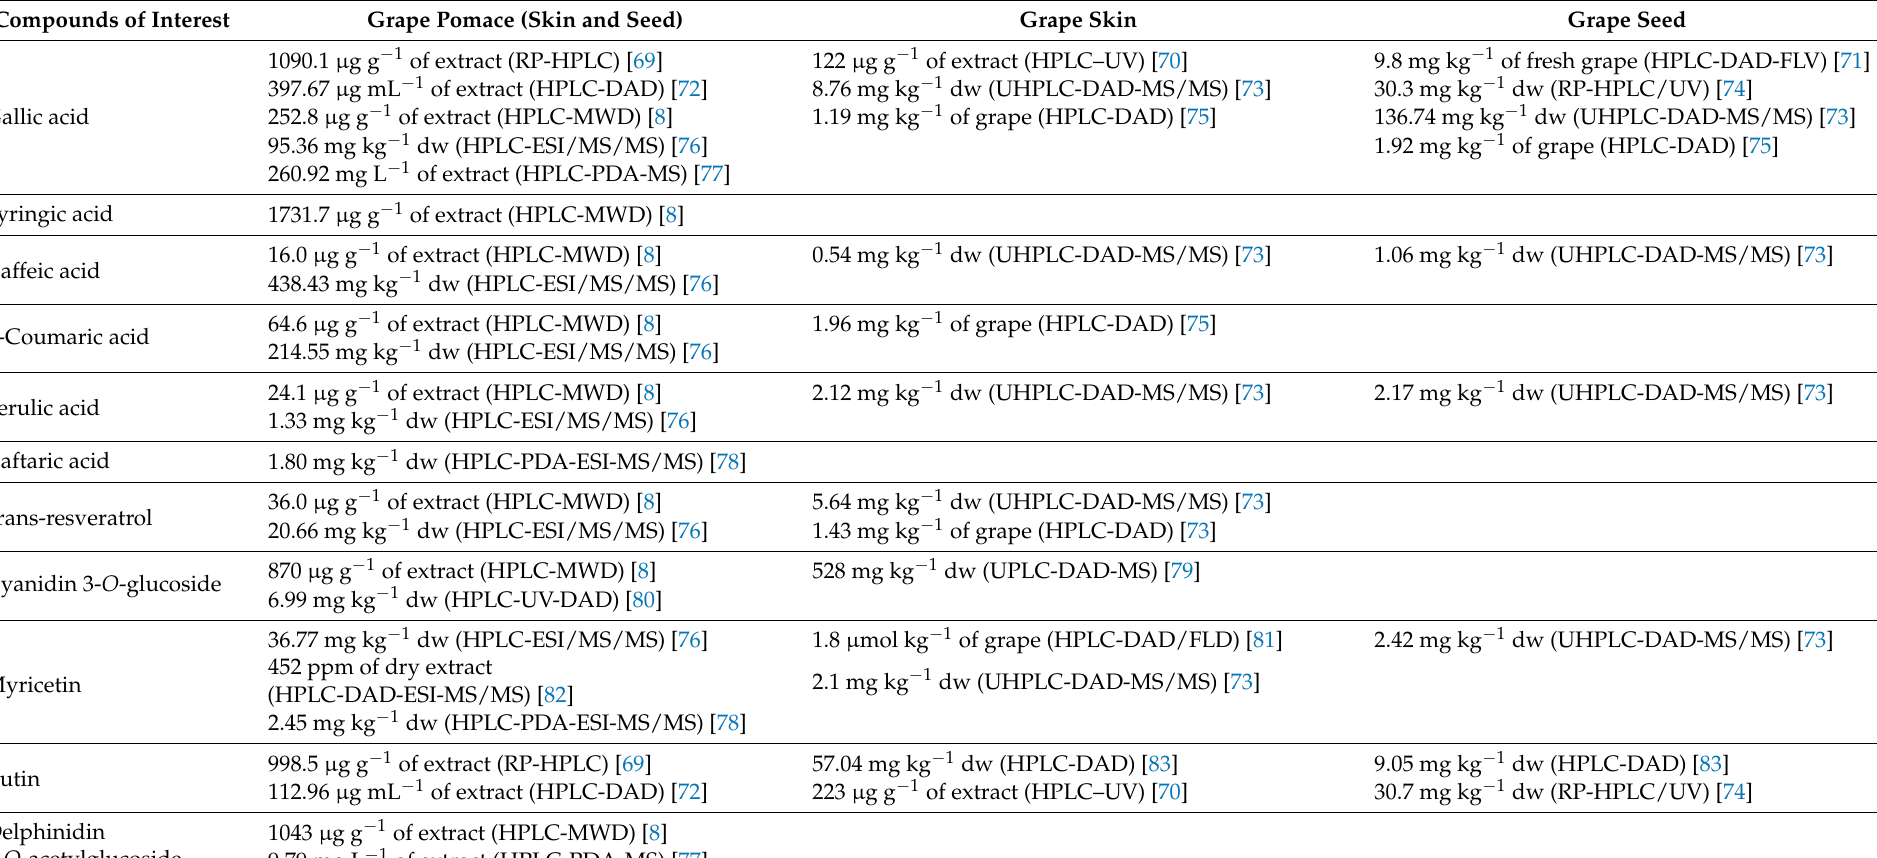
Table A1. Main bioactive compounds found in pomace